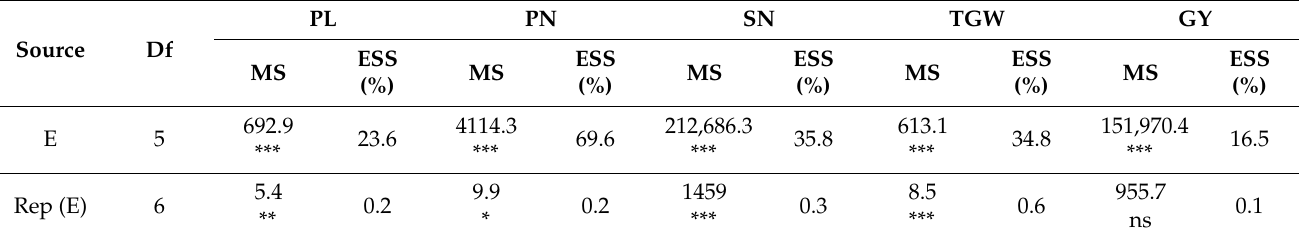
Table 1. Combined analysis of variance (ANOVA) of yield-component traits and grain